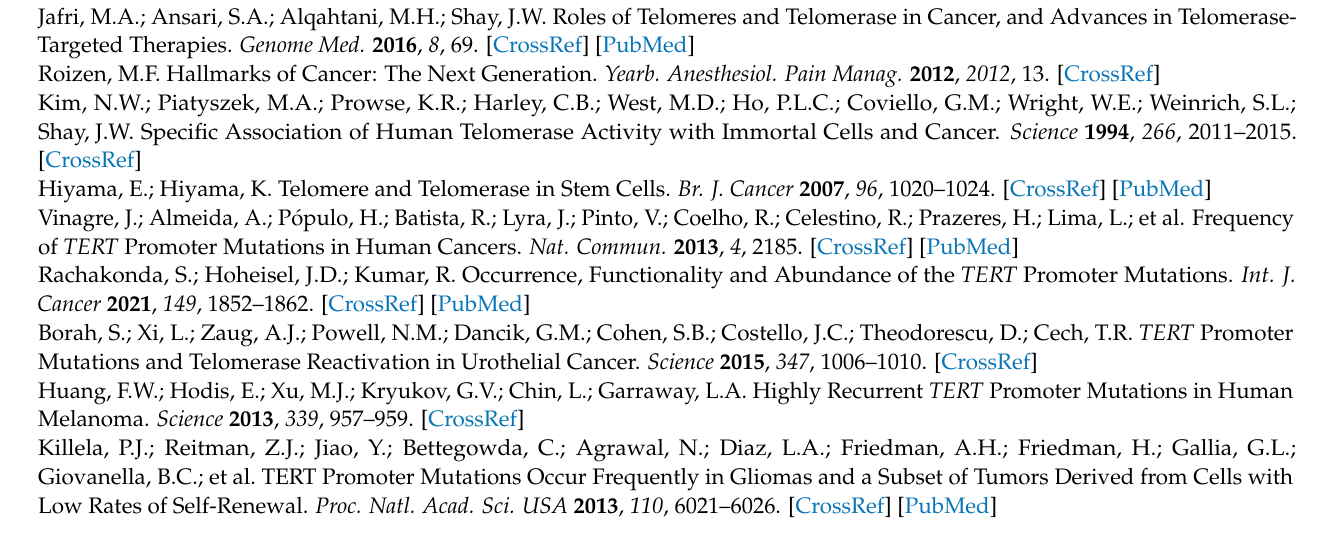
Figure S4: Direct binding of hTERT G4 variants bearing the 5 (cid:48) -TAMRA label with ecMutS; Figure S5: Competitive binding of ds76-G/T-3 (cid:48) bearing the TAMRA label at the 3 (cid:48) -end of the bottom strand from the preformed complex with ecMutS by unlabeled hTERT G4 DNA variants; Table S2: IC 50 values and calculated K Iapp values for ecMutS complexes with hTERT G4 variants; Figure S6: Direct binding of hTERT G4 variants bearing the 5 (cid:48) -TAMRA label with ecMutL; Figure S7: Direct binding of ngMutL to ssDNA models containing G4 motifs and dsDNA control; Figure S8: Cleavage of 3 (cid:48) -TAMRA-labeled 76-nt ssDNA and 76-bp dsDNAs that either do not contain a mismatch or contain a G/T mismatched base pair, by ngMutL in the presence of an equimolar amount of ng β ; Figure S9: ngMutL-induced hydrolysis of duplex WT-3 (cid:48) /WT-C and its altered